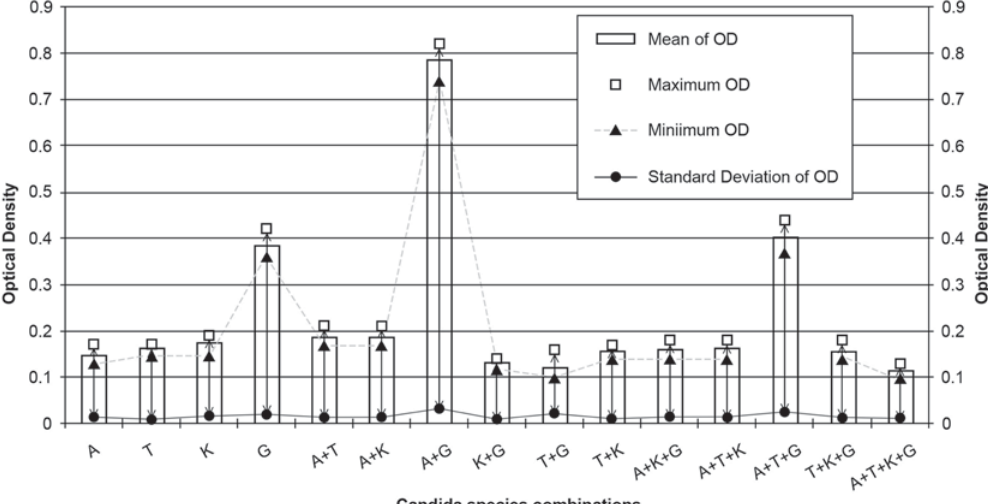
## OD., Optical Density; A., C. albicans ; T., C. tropicalis ; K., C. krusei ; G., C. glabrata; +, Combination of tested Figure 1- Optical Density of de-staining solution